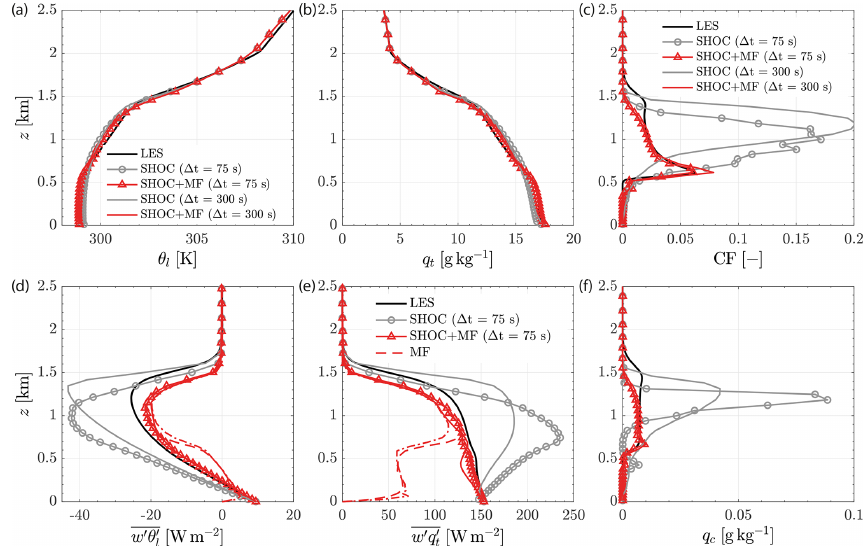
Figure 9. Sensitivity of the SCM results to the time step for the BOMEX case. Vertical profiles of (a) liquid water potential temperature, (b) total water mixing ratio, (c) cloud fraction, (d) turbulent heat flux, (e) turbulent moisture flux, and (f) cloud water mixing ratio for LES (solid black line), SHOC (solid grey line), SHOC + MF (solid red line), and MF (dashed red line). The results obtained using (cid:49)t = 75s are represented by solid lines with markers (circles for SHOC and triangles for SHOC + MF), whereas the results obtained using (cid:49)t = 300s are represented by plain solid lines. All simulations used the L128 vertical grid. The profiles correspond to a time average over t = 4–6h.